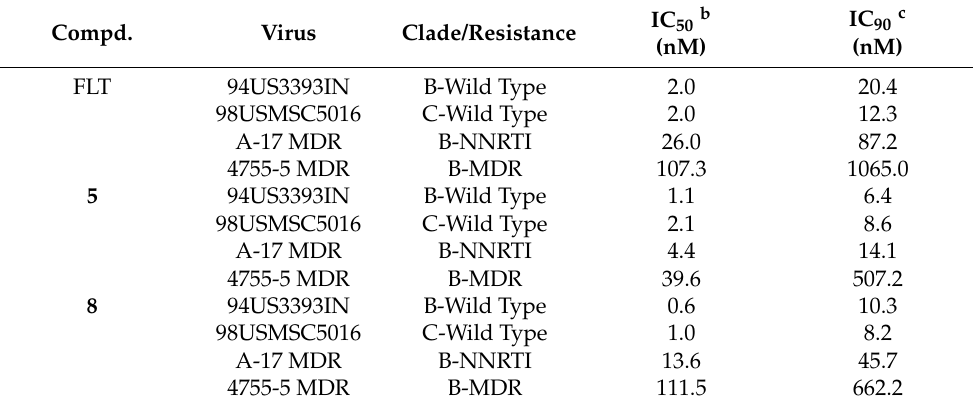
Table 4. Anti-HIV evaluation against wild type clinical isolates and resistant virus a .